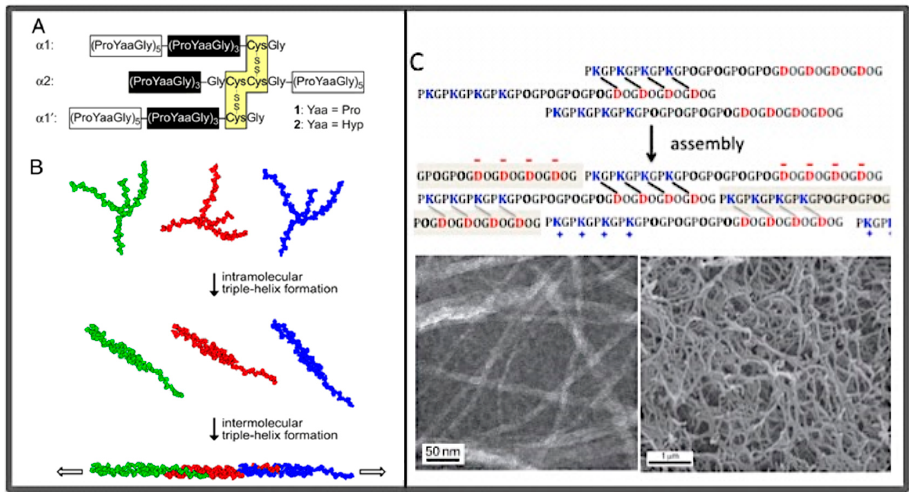
Figure 4. The "sticky end” approach for the self-assembly of collagen mimetic peptides (CMPs). ( A ) The cross-linked CMP with sticky ends. ( B ) The self-assembly process to form a super triple helix [124]. ( C ) The charge-pair directed self-assembly of the KOD peptide, and the TEM images of the KOD fibrils (left, the scale bar is 50 nm), and the hydrogel formed by KOD (right, the scale bar is 1 µ m). The directional, interchain Lys-Asp salt brides of the nucleation site are highlighted by short, slanting